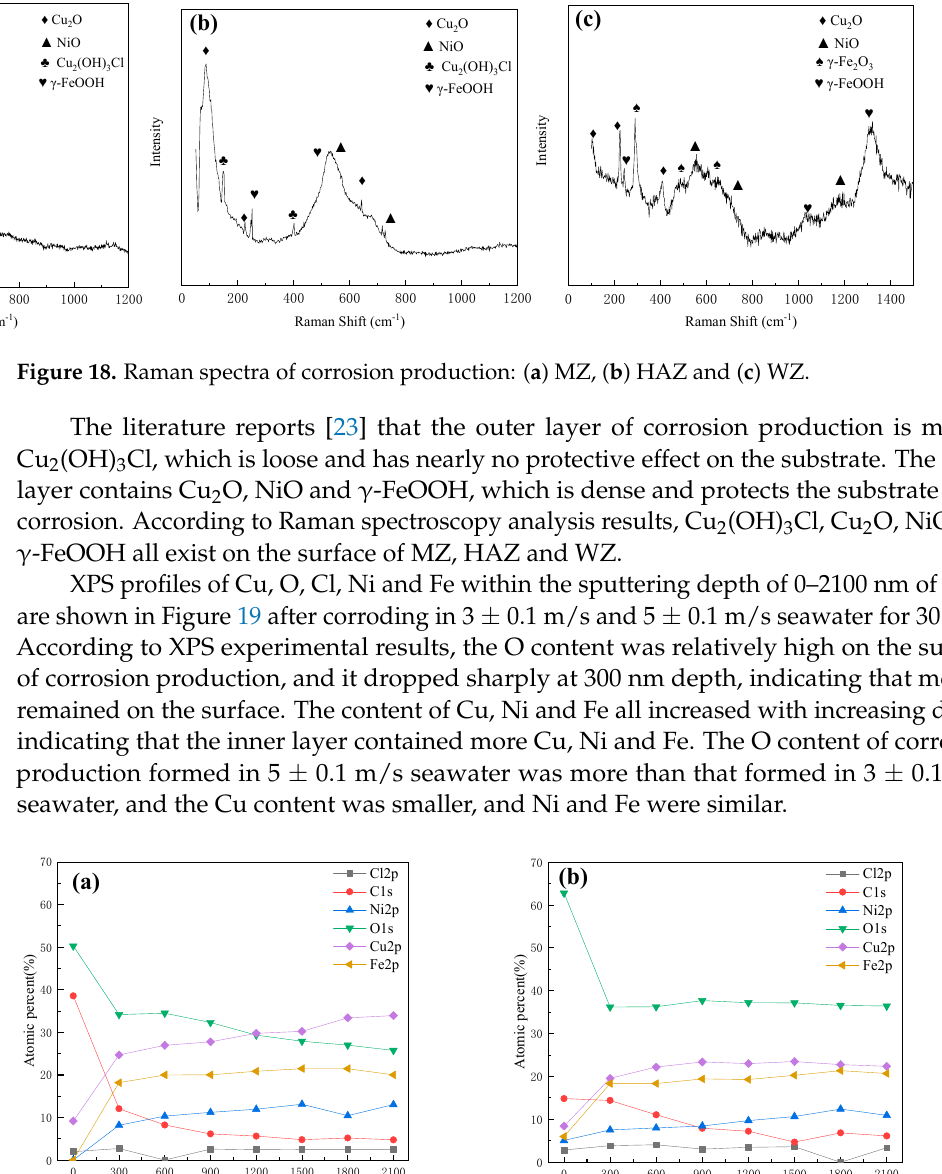
Figure 19. XPS depth profiles of Cu, O, Cl, Ni and Fe of HAZ corroded for 30 days in flowing sea- water: ( a ) 3 m/s, ( b ) 5 m/s.